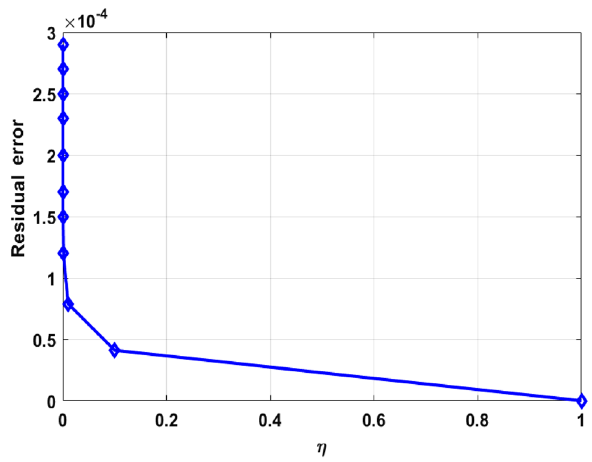
Figure 11. Residual error in the numerical solution by shooting method against η .